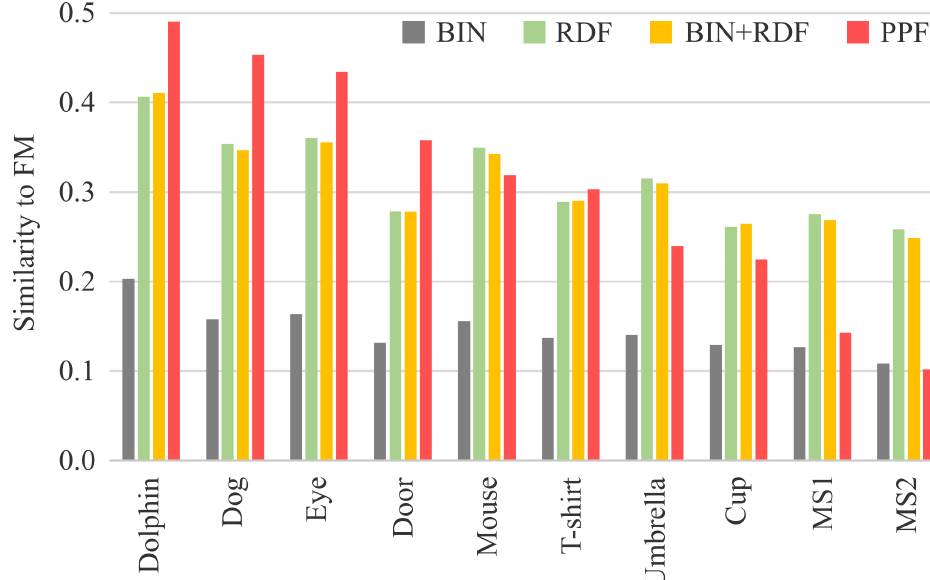
Figure 6. Graph of the similarity values in Table 1.